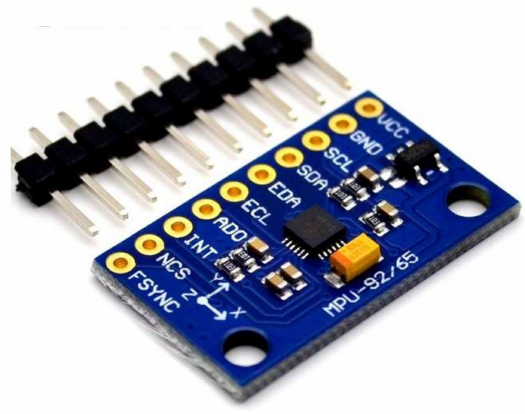
Figure 12. The 9 DoF IMU, MPU-9250 breakouts